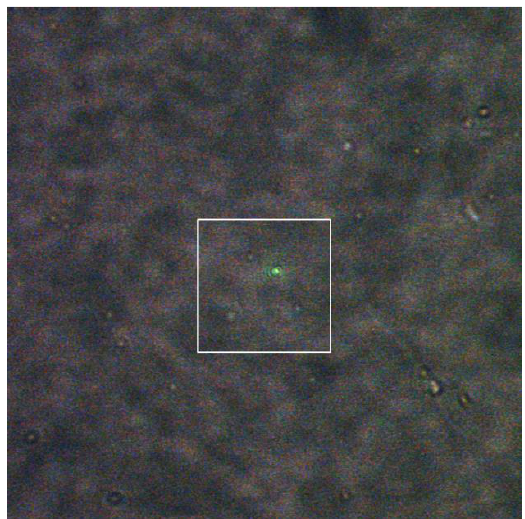
Figure 1. A wide-field optical microscopic image showing bright scattering spots due to nanoparticles. The white square marks the area (9 µm × 9 µm ) to obtain the atomic force microscopy (AFM) image as shown in Figure 2(a,d), and the greenish light spot shows that the focused laser spot hits on one of the nanoparticles.